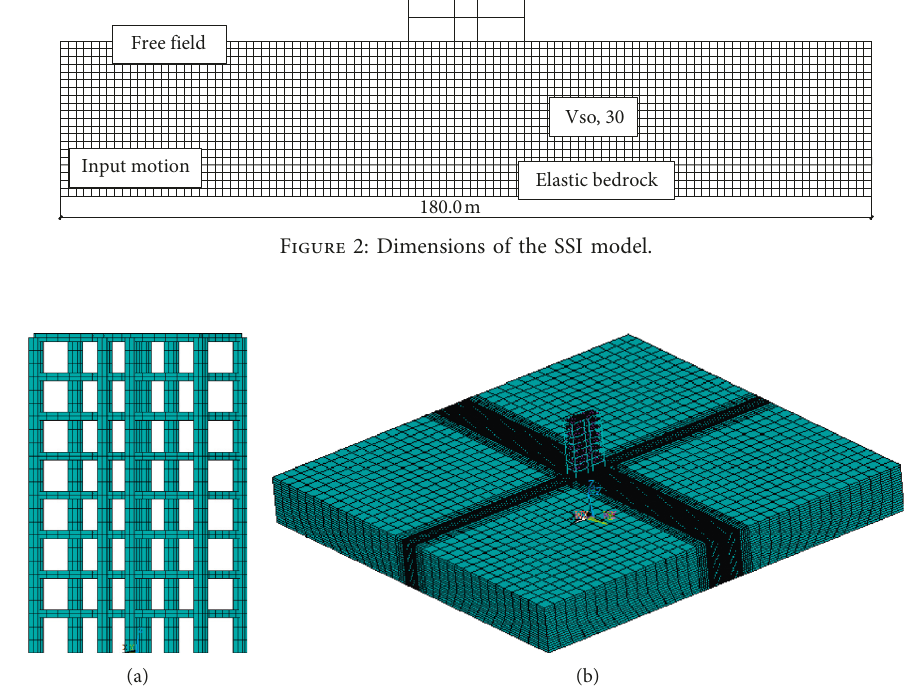
Figure 3: Three-dimensional finite element meshes of the structure adopted in this study. (a) Fixed-base model and (b) SSI